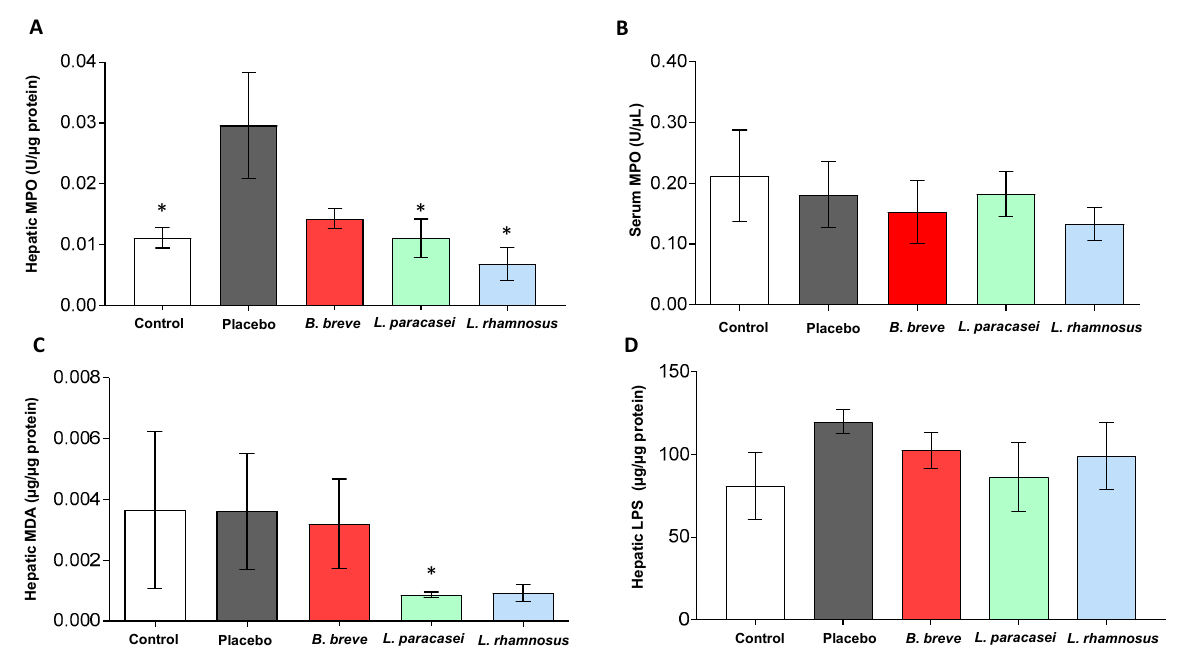
Figure 6. Hepatic levels of ( A ) MPO, ( C ) MDA and ( D ) LPS, and serum levels of MPO ( B ) of rats fed either with placebo, B. breve CNCM I-4035, L. paracasei CNCM I-4034 or L. rhamnosus CNCM I-4036 for 30 days. Values are the means ± SEM, n = 3–5 per group. * p < 0.05 vs. placebo. B, Bifidobacterium; L, Lactobacillus ; LPS, lipopolysaccharide; MDA, malondialdehyde; MPO, myeloperoxidase.